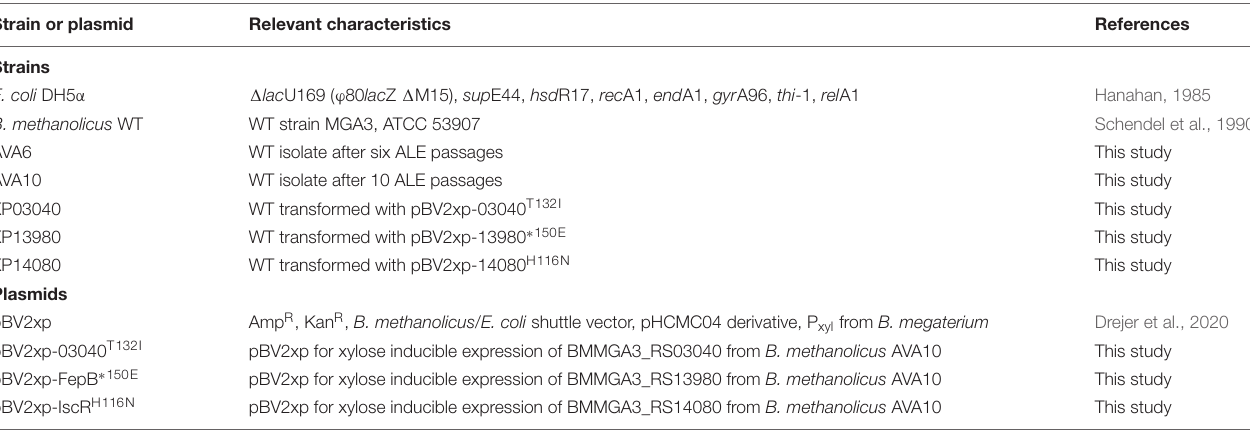
TABLE 1 | Strains and plasmids used in this